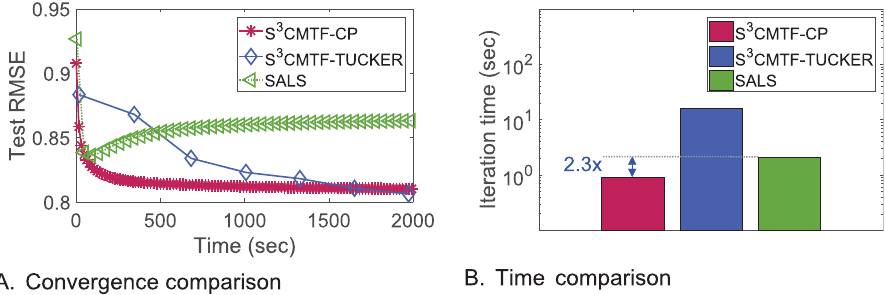
Fig 5. Comparison with SALS-single for movieLens dataset. We compare two non-coupled version of S 3 CMTF, S 3 CMTF-CP-opt and S 3 CMTF-TUCKER-opt with the parallel CP decomposition method, SALS-single. For (a), we set 1 mark per 20 iterations for clarity. (a) S 3 CMTF converges faster to a lower error than SALS does. (b) S 3 CMTF-CP-opt is 2.3 × faster than